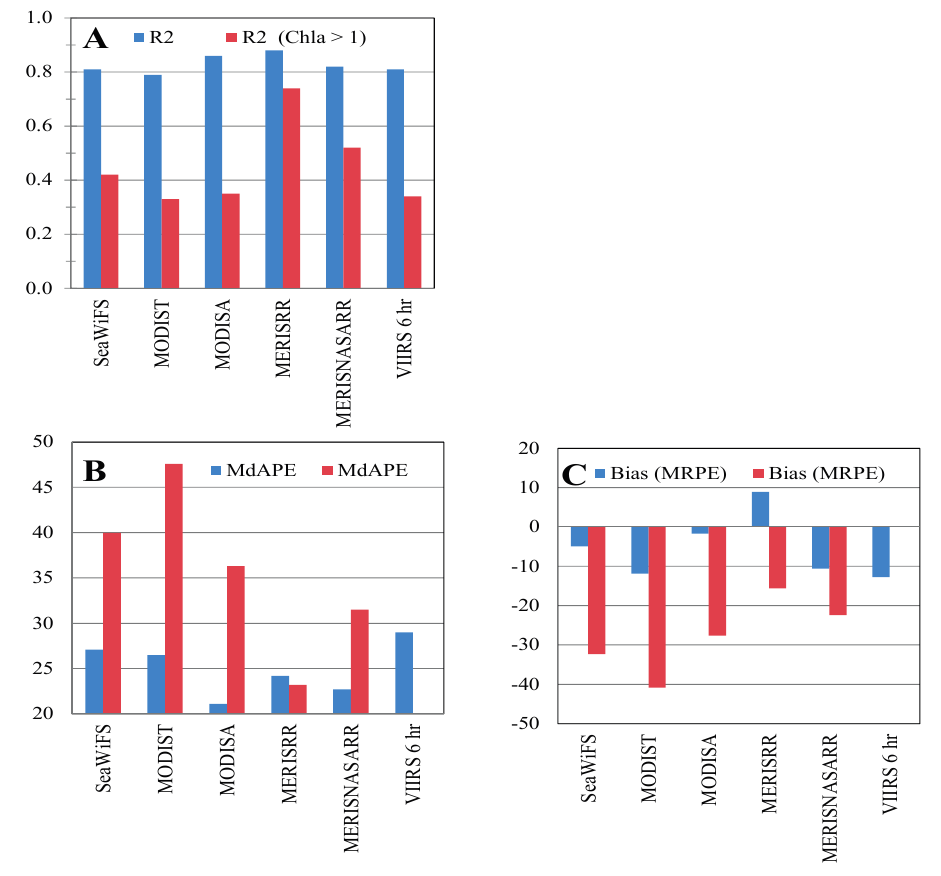
Figure 4. Statistics of chlorophyll-a retrievals by multiple satellite sensors for the full range of in situ Chla (blue) and for in situ Chla ≥ 1 mg m − 3 (red): ( A ) coefficient of determination, R 2 ; ( B ) median absolute percent error (MdAPE, %); ( C ) bias or median relative percent error (MRPE,